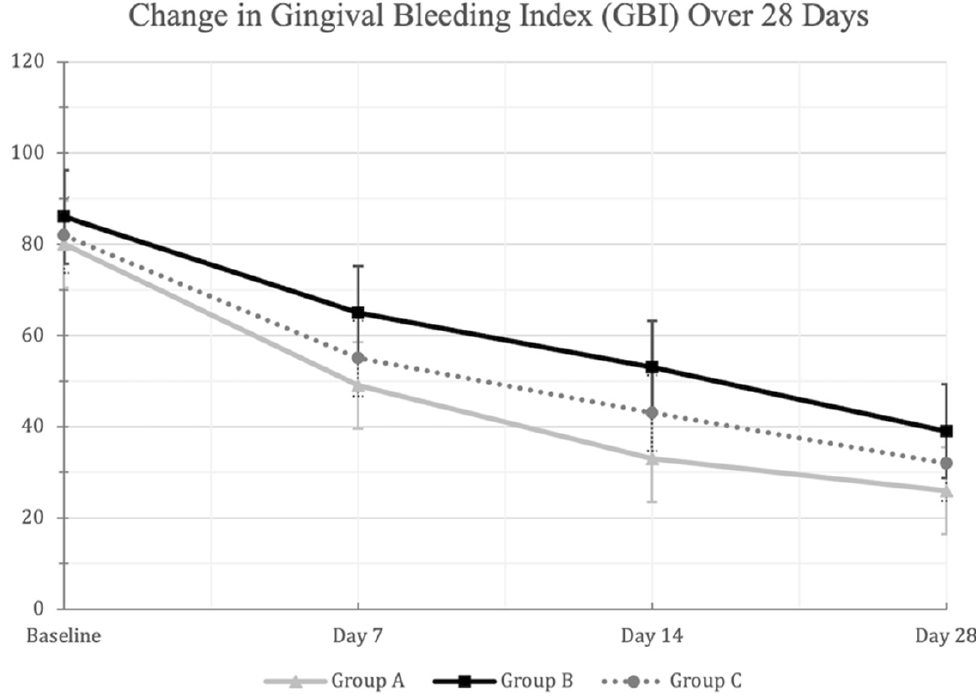
Figure 3. A line-chart showing the decrease in the mean ( ± SD) Gingival Bleeding Index (GBI) scores in the three mouthwash groups at the different examination times. Changes from baseline to Day 28 were statistically significant within each mouthwash group at the 0.01 level using repeated measures ANOVA. [Group A: Green Tea (Warm MW), Group B: Green Tea (Hot-Ice MW), Group C: Placebo]. Table 3. Post hoc analysis for the comparisons between the three mouthwash (MW) groups with regards to the Gingival Bleeding Index (GBI) at the different examinations. p values in bold fonts are statistically significant at the 0.01 level using Fisher’s Least Significant Difference (LSD).